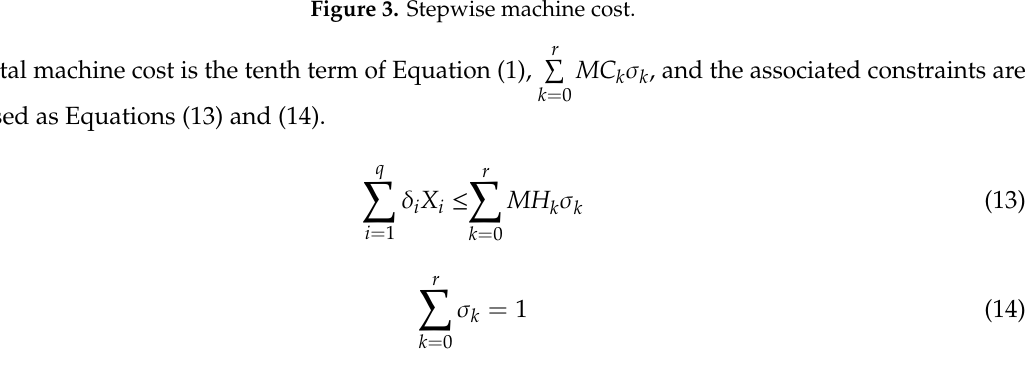
Figure 3. Stepwise machine cost.